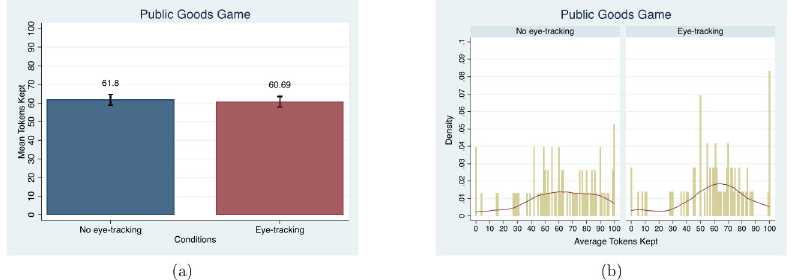
Fig 7. Mean and distribution comparisons in the average number of tokens kept in 10 periods. Note. Red lines in (b) present the univariate kernel density estimation.